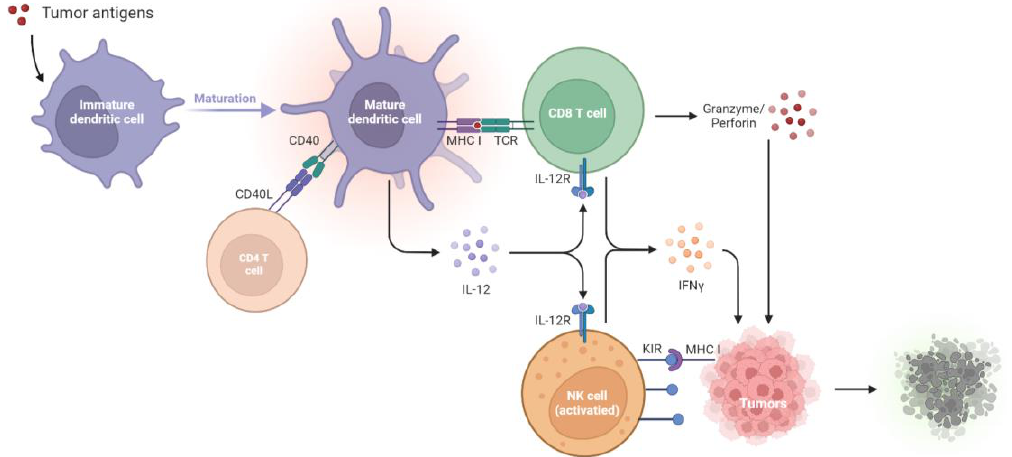
Figure 1. Tumor suppression by the immune systems during immunosurveillance. Once tumor antigens are captured, immature DCs undergo maturation. The mature DCs present the antigens onto MHC I molecules for presentation to CD8 + T cells. The CD40L on the CD4 + T cell stimulates CD40 on the DCs, which delivers help signals to CD8 + T cells. With the CD40–CD40L interaction, the amplification of IL-12 in DCs promotes the development of antigen-specific CD8 + T cells and thus increases the IFN- γ , granzyme, and perforin production to kill tumors. NK cells will be activated by the diminished expression of MHC I on tumors, which relieves the KIR inhibitory signaling and activates the NK cell toxicity towards tumors. CD40L, CD40 ligand; DCs, dendritic cells; IL- 12R, IL-12 receptor; IFN- γ , interferon- γ ; KIR, killer immunoglobulin-like receptor; MHC I, major histocompatibility complex class I; NK cells, natural killer cells; TCR, T cell